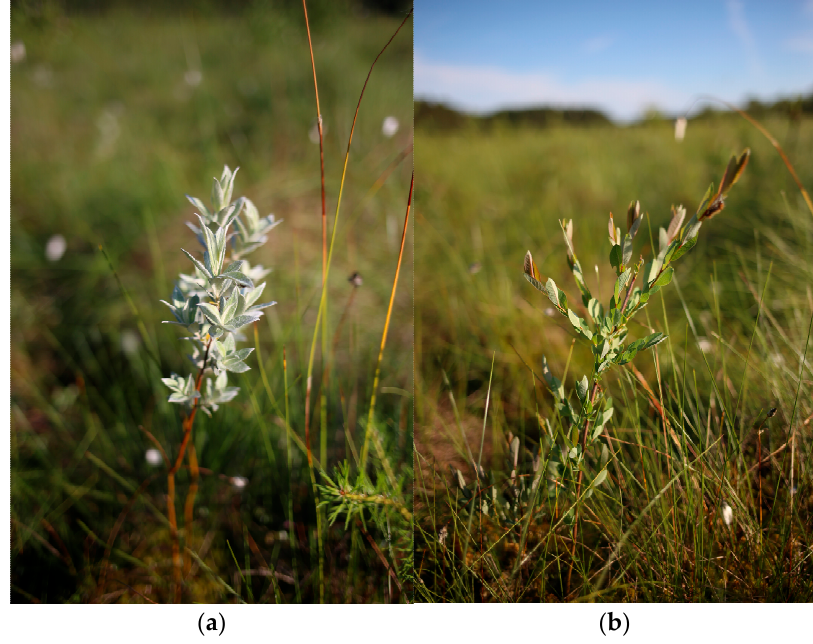
Figure 2. Plant individuals in newly established populations ( a ) S. lapponum ; ( b ) S. myrtilloides.